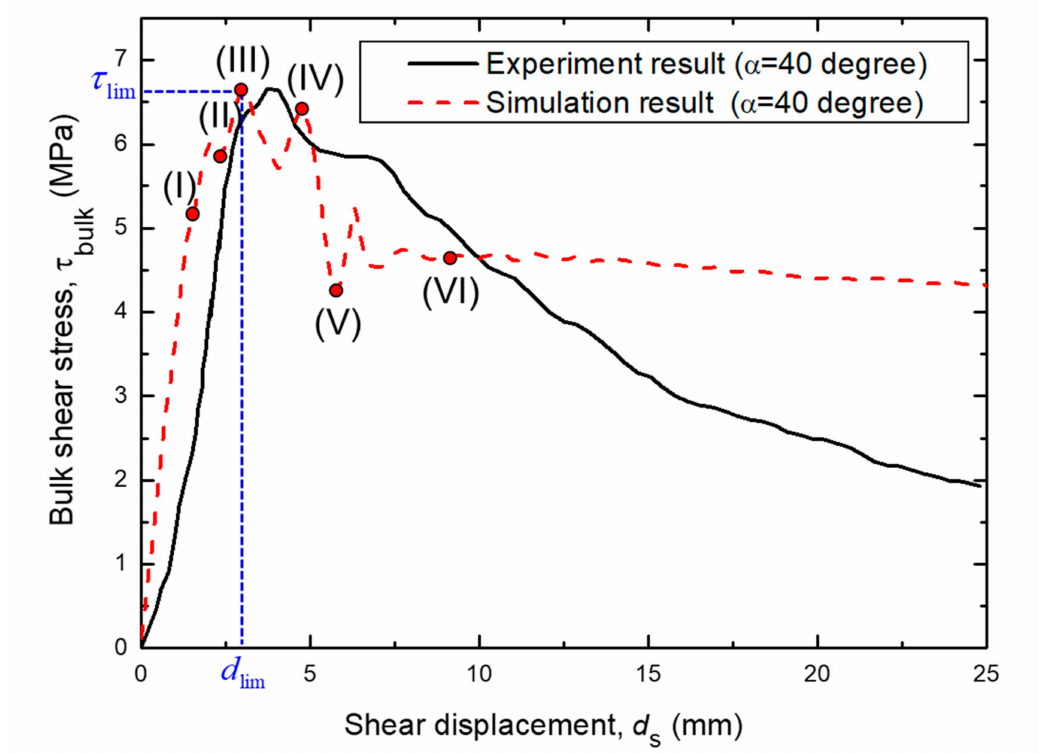
Figure 10. Shear stress vs. shear displacement curve obtained during the simulation of a direct shear test with rough concrete–rock joint fracture process with an asperity angle α = 40 degrees ( σ n = 3